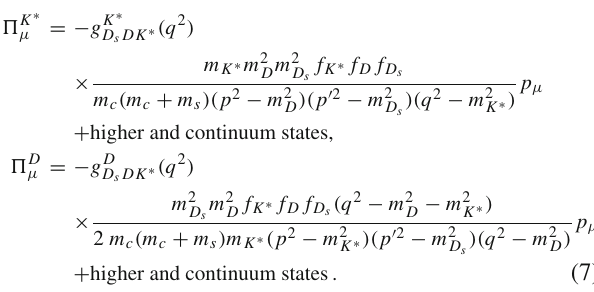
( 5 ) ¯ (cid:18)(cid:18) | C 0 (cid:6) [18]. μ (cid:4) 0 | 0 ( 3 ) ( 5 ) μ and C μ